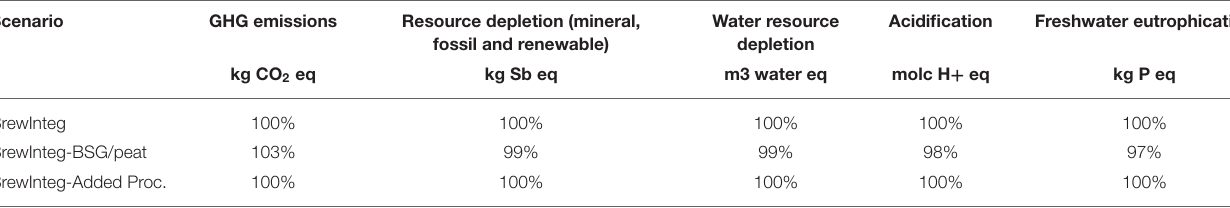
TABLE 5 | Testing the sensitivity to different assumptions for the use of brewers’ spent grain (BSG).